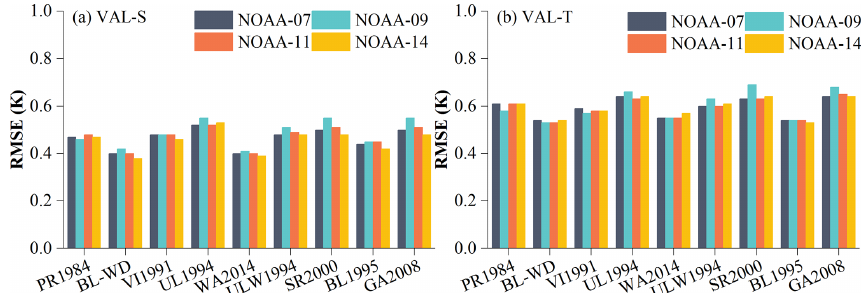
Figure 4. Performance of the nine selected SWAs for simulation datasets VAL-S and VAL-T.